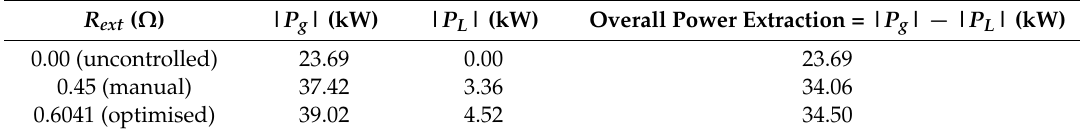
Table 5. Overall power extraction for dP = |7000 sin (0.314 t )| Pa.